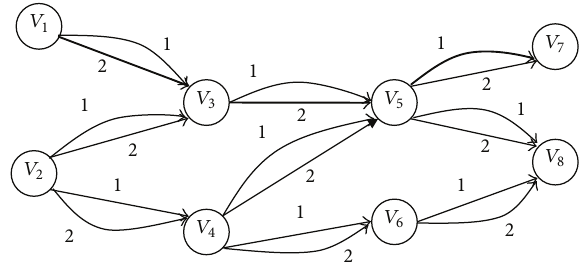
Figure 1: Directed graph with 8